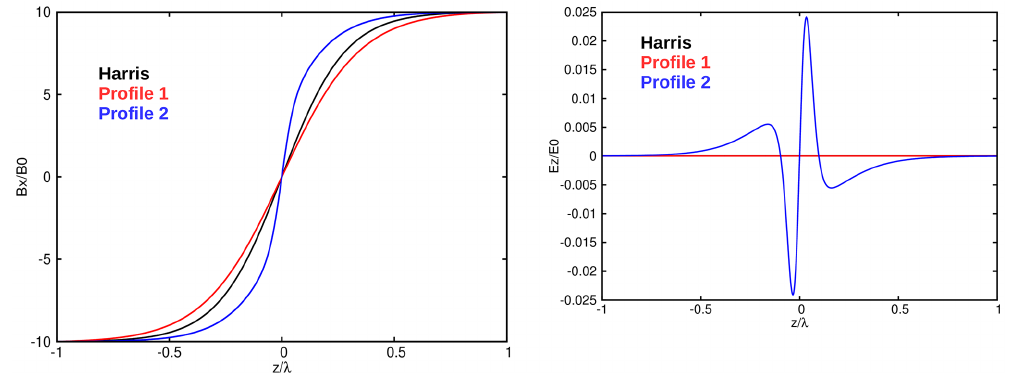
Figure 2. Model profiles of B x (z) and E z (z) , the black line represents the Harris solution, the red line the solution with lower slope in B x , and the blue line the profile with higher slope.